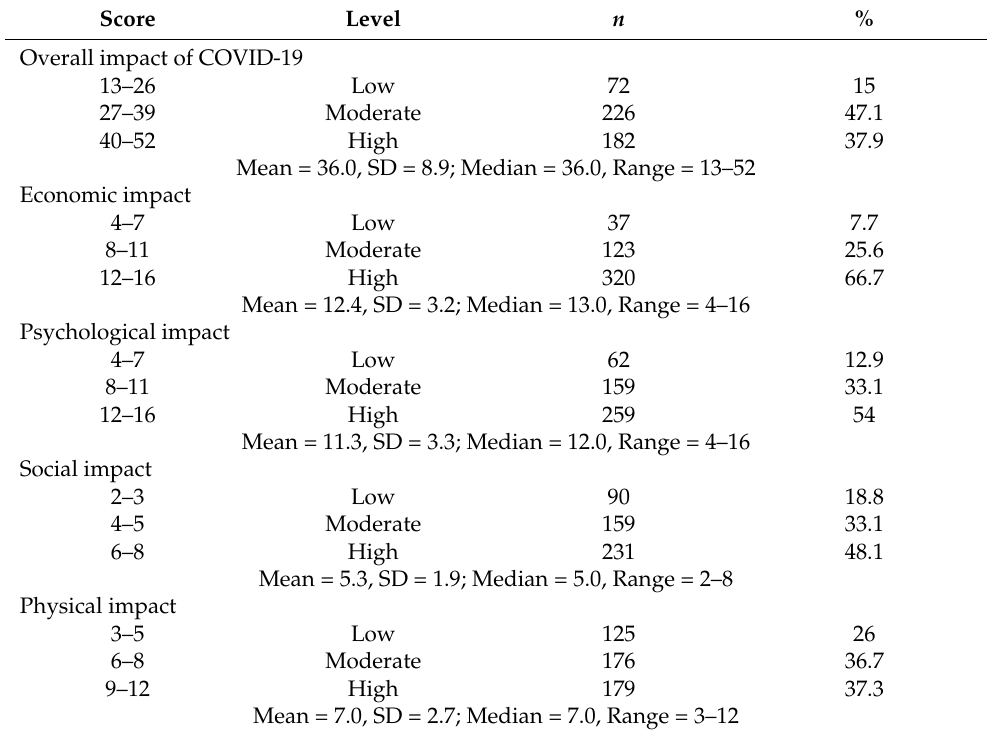
Table 5. Impact of COVID-19 among participants ( n =